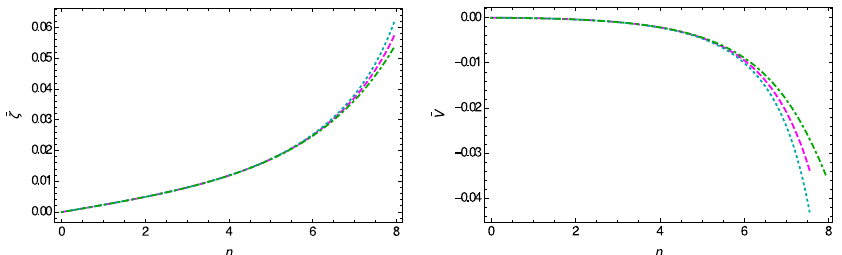
dashed curve), respectively. The central density of the photon star is ρ tively